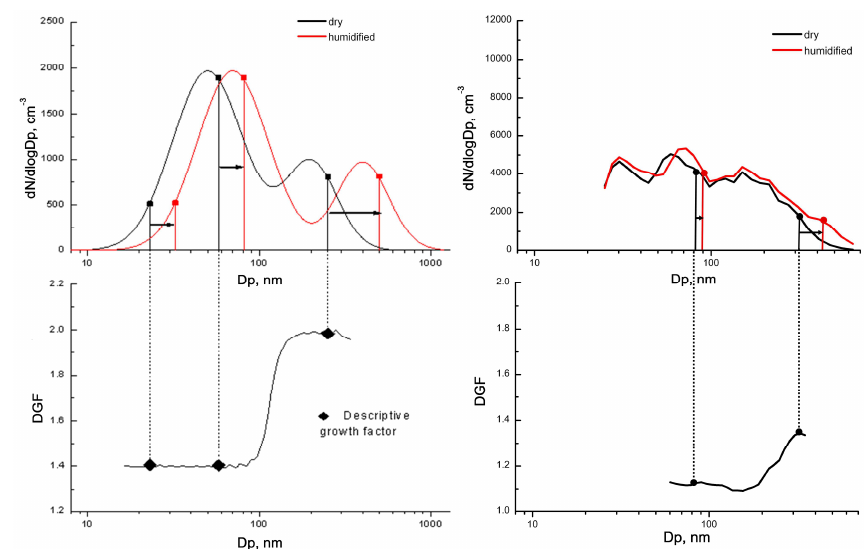
Fig. 1. Dry and humidified size distributions and the corresponding DGF calculated by the summation method. The left panel has been adapted from Nowak (2006). The right panel shows data from the Paris summer campaign.